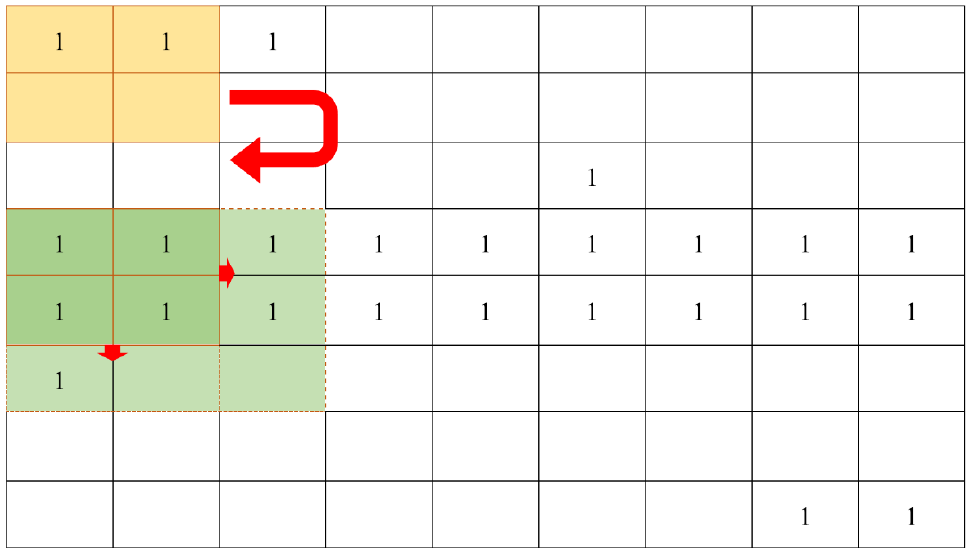
Figure 4. Schematic diagram of adaptive window.